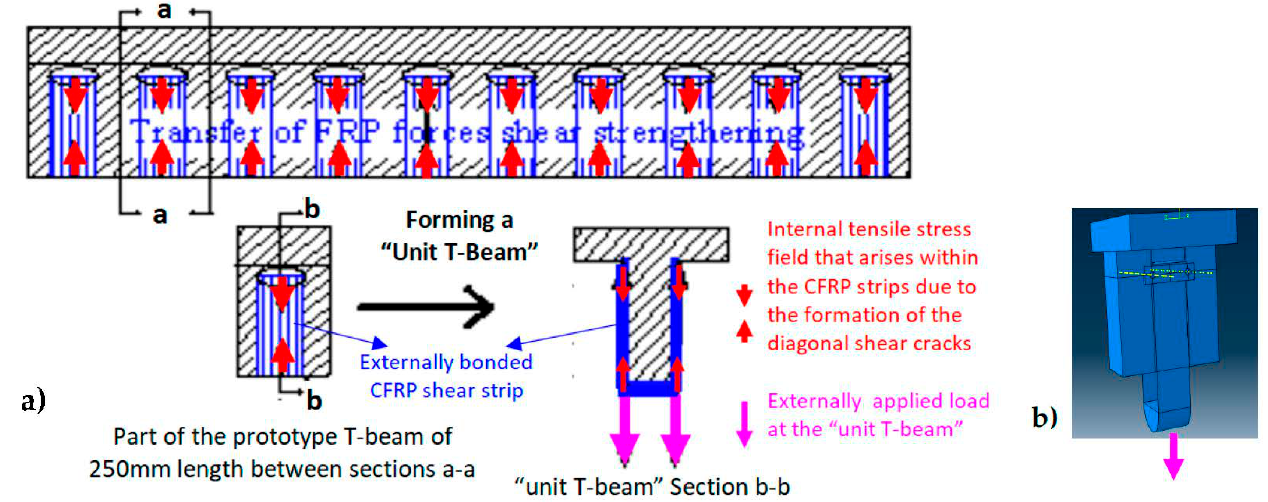
Figure 6. ( a ) Typical tensile test results of longitudinal reinforcement. ( b ) Typical tensile test results of CFRP strip.